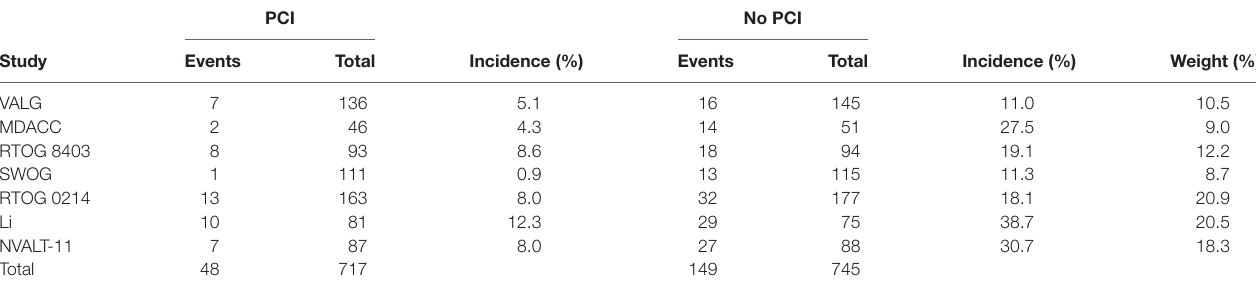
TABLe 2 | Data on BM events [(a)symptomatic BM occurrence] and incidence of the included RCTs evaluating PCI. PCi No